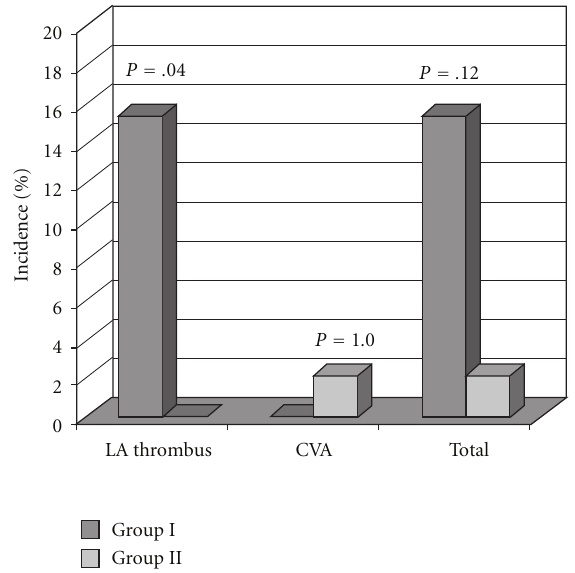
Figure 3: Histogram showing incidence of left atrial (LA) thrombi, cerebrovascular accidents (CVA), and the combined event rate. LA thrombi occurred more frequently in group I patients ( P = .